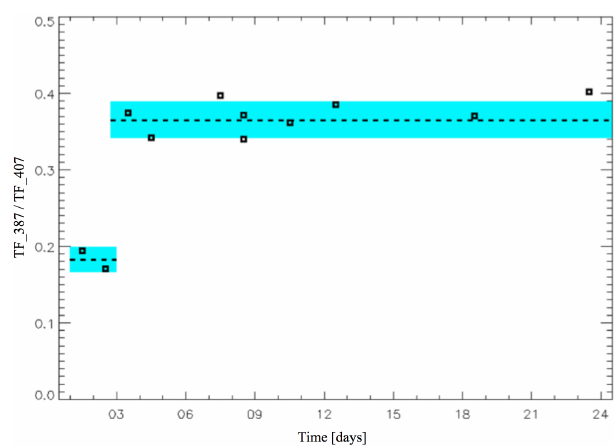
Figure 4. Temporal evolution of the transmittance functions of the two Raman channels measured through the lamp method during the MALICCA campaign. Dashed horizontal lines represent the median values, while the blue light region defines the residual variability (mean ± standard